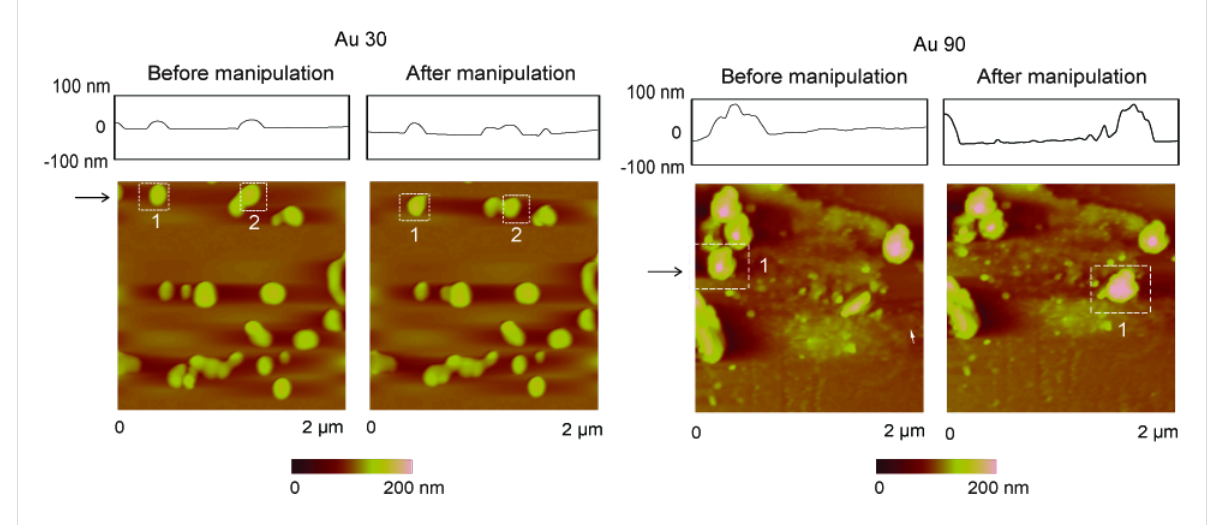
Figure 5: Two examples of topography maps and height profiles, at sections shown by the arrows, of Au 30 and Au 90 nanoparticles highlighted by the squares, manipulated within the same scan area. For Au 30, nanoparticles 1 and 2 are moved, and for Au 90, nanoparticle 1 is moved.